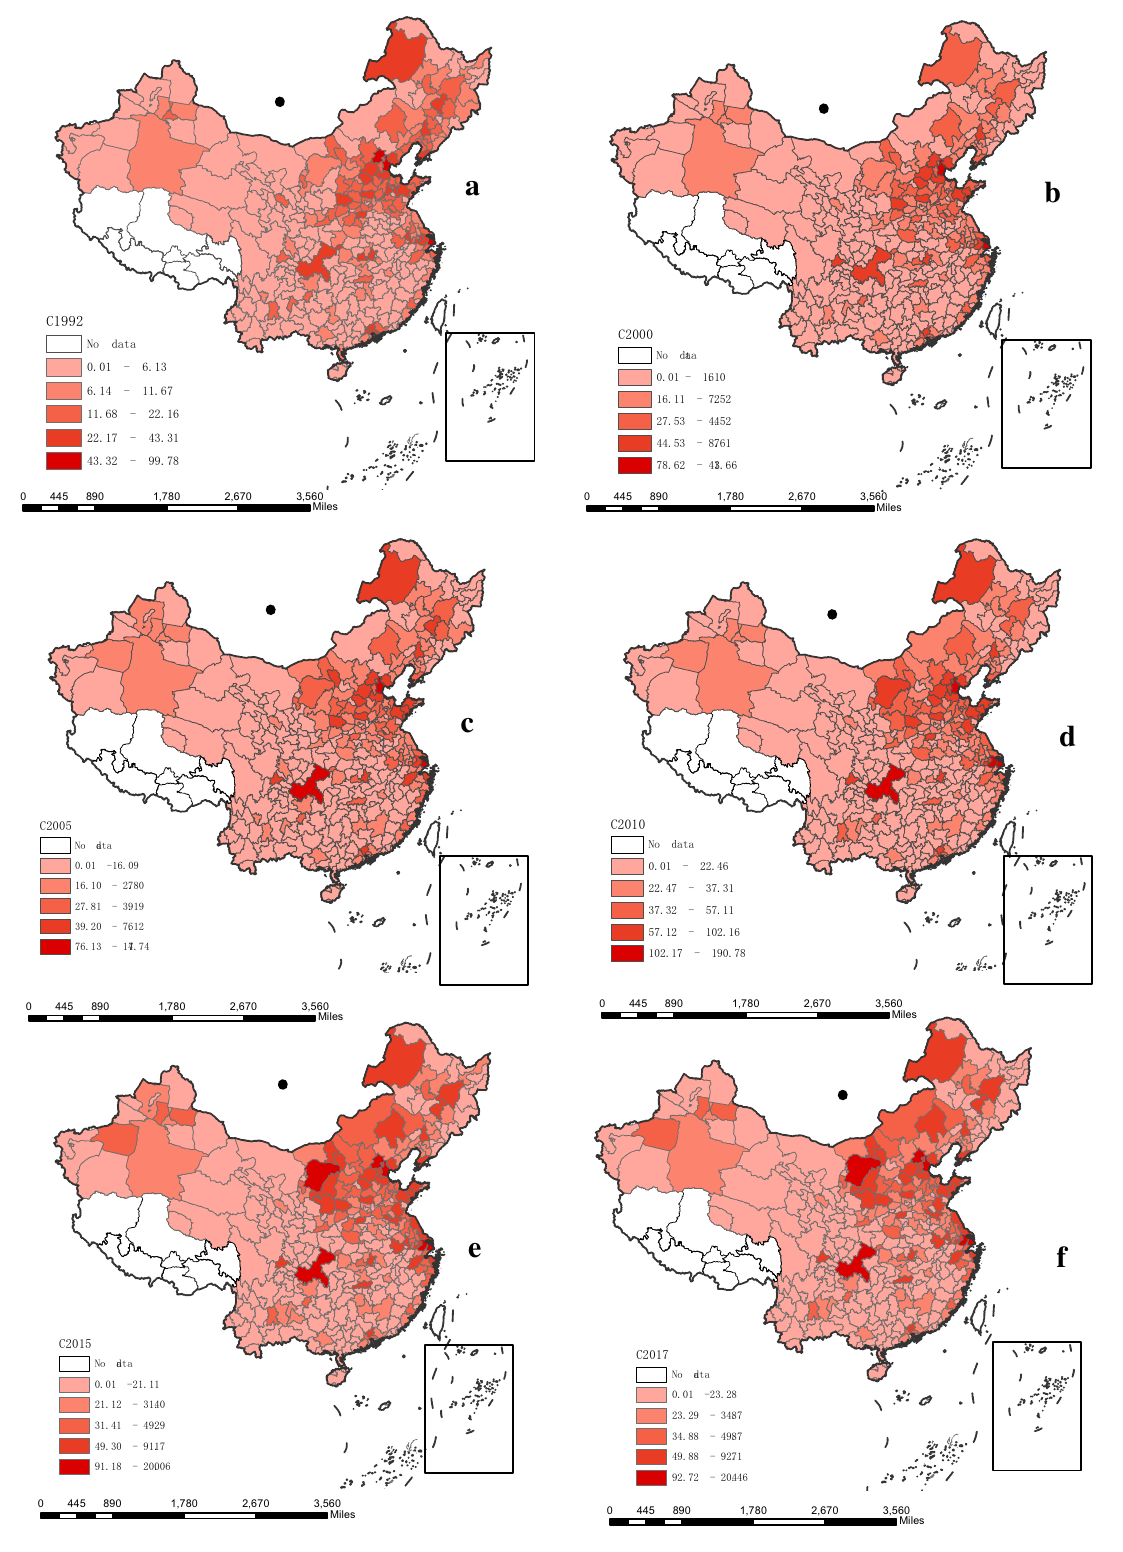
Figure 3. Spatial and temporal pattern of China’s city-level carbon emissions during 1992–2017 (unit: million tons). ( a ) 1992, ( b ) 2000, ( c ) 2005, ( d ) 2010, ( e ) 2015, and ( f ) 2017. Note : These images were made by ArcGIS 10.0. The version is available from: https ://www.esri.com/en-us/arcgi s/produ cts/arcgi s-maps-for-offic e/downl